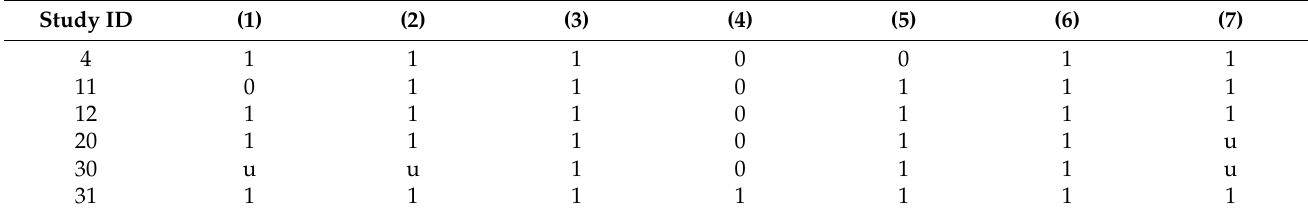
Table A3. RCT quality assessment.